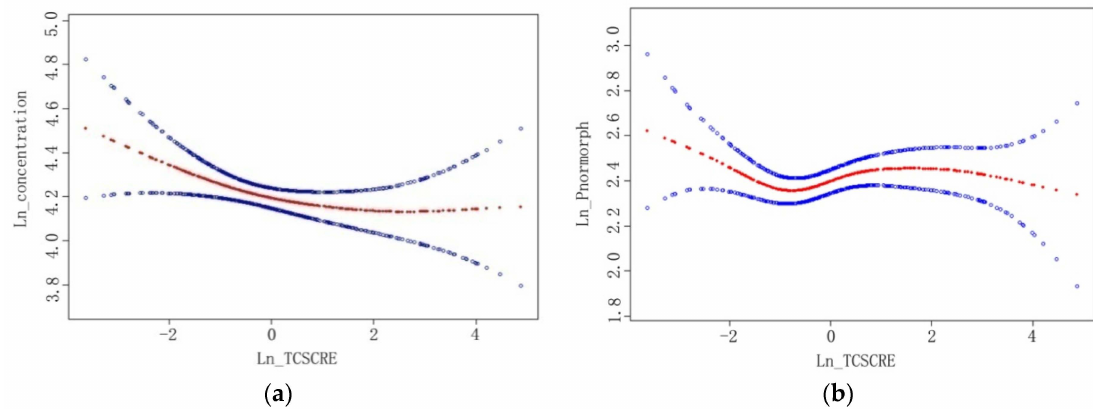
Figure 3. The relationships between triclosan (TCS) and sperm concentration and percent of normal morphology sperm among Chinese men (471) recruited during November 2013–March 2014. The x -axis refers to natural logarithm-transformed urinary TCS level corrected by creatinine concentration (Ln_TCSCRE); The y -axis refers to natural logarithm-transformed sperm concentration (Ln_concentration) ( a ) and percent of normal morphology sperm (Ln_Pnormorph) ( b ). The red line is fitted by generalized additive model showing the relationship between x and y axes. The two blue lines refer to 95% confidence intervals. All models were adjusted for age, BMI, abstinence period, education, income, current smoking, drinking and exposure to other chemicals or heavy